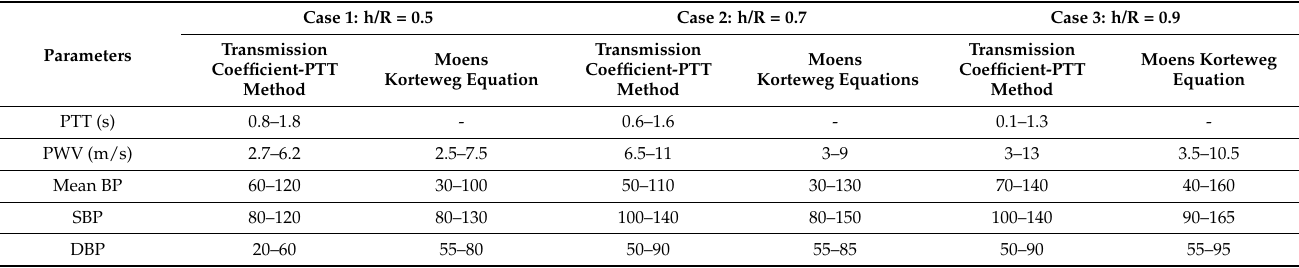
Figure 20. ( a ) Relationship between pulse-wave velocity and systolic blood pressure (in mmHg); ( b ) elationship between pulse-wave velocity and diastolic blood pressure (in mmHg). Table 8 shows the summary of the two methods. There is a good consistency between the results of the two methods. According to the results, by comparing the PWV, SBP and DBP values, both models show good agreement and high accuracy in a systematic and detailed algorithm. Table 8. Summary table comparing the two proposed methods for blood pressure